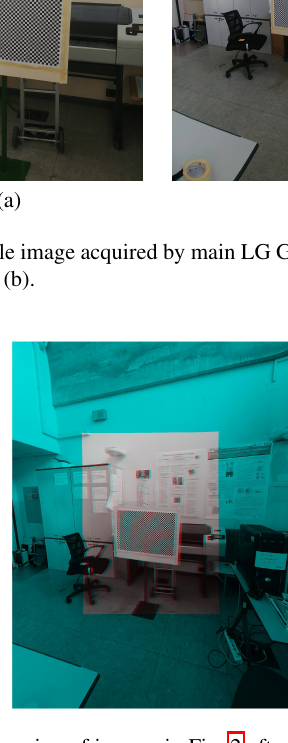
Figure 3. Overlapping of images in Fig. 2 after rectification and